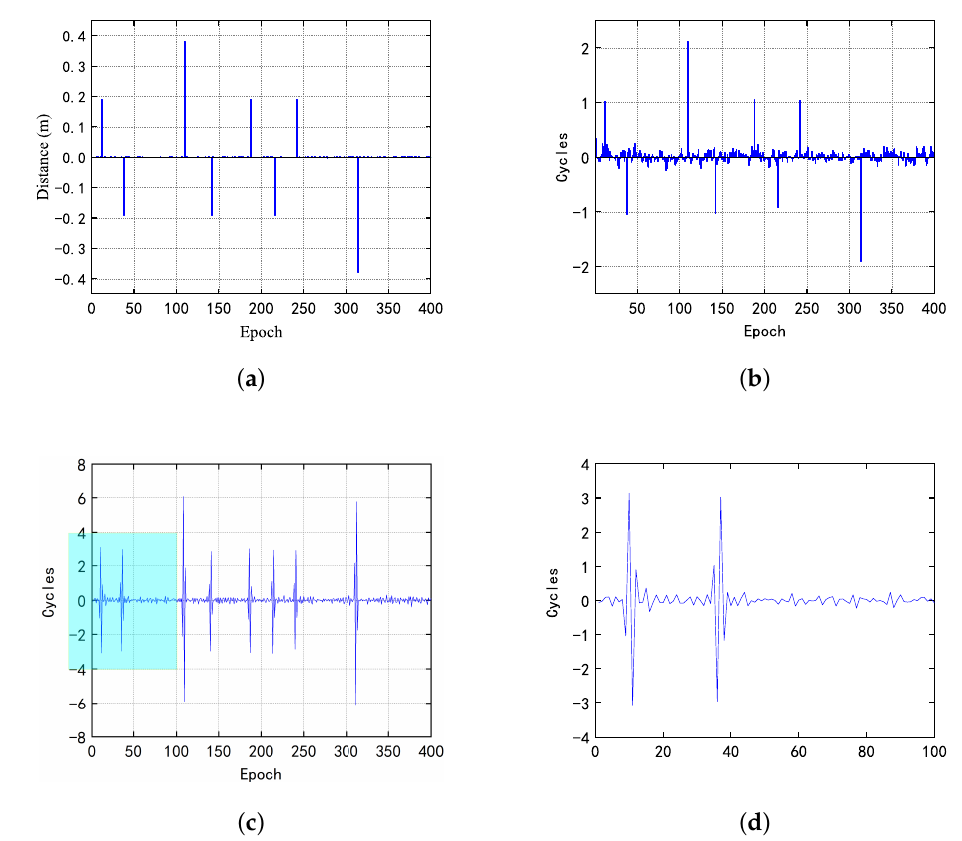
Figure 6. In the first case, ( a ) the results obtained by the proposed indoor dual-frequency cycle slip detection method; ( b ) Doppler method; ( c ) high-order difference method; and ( d ) its details of enlarged local